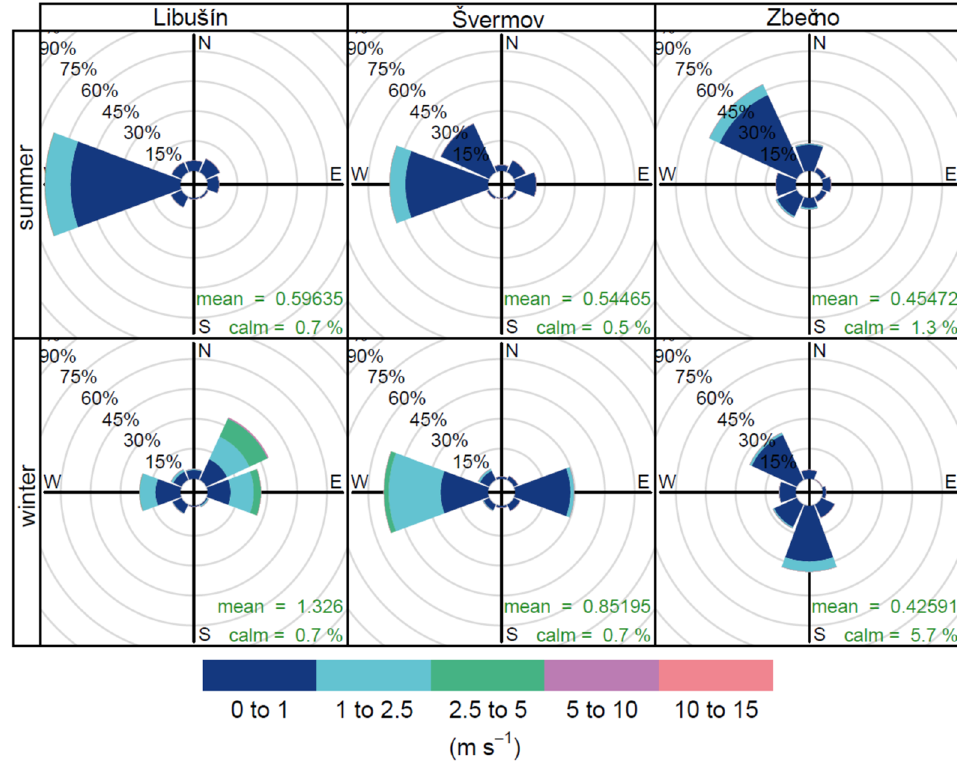
Figure 2. Seasonal wind roses representing the sampling periods.